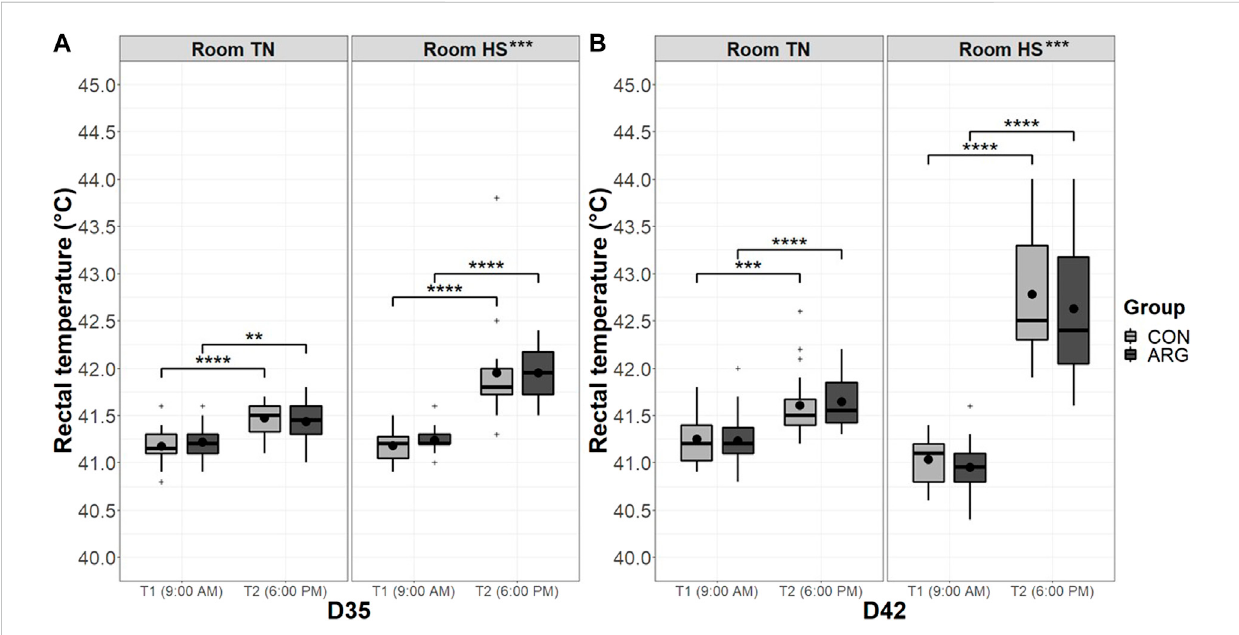
FIGURE 3 Rectal temperature of CON and ARG birds in the two rooms on the fi rst (A) and eighth (B) day of the cyclic HS period at two time points. Note: The rectal temperature of 18 labeled birds/group/room was measured on the fi rst (D35) and the eighth (D42) day of the cyclic HS period at two time points, namely T1(9:00 AM)andT2(6:00 P.M.). Groupmeansare theblack dotsinsidetheboxes. **, p < 0.01; ***, p < 0.001; ****, p < 0.0001.TN,thermoneutral conditions; HS, (cyclic) heat stress conditions; T1/2, time point 1/2; D#, day#; CON, control group; ARG, arginine-supplemented